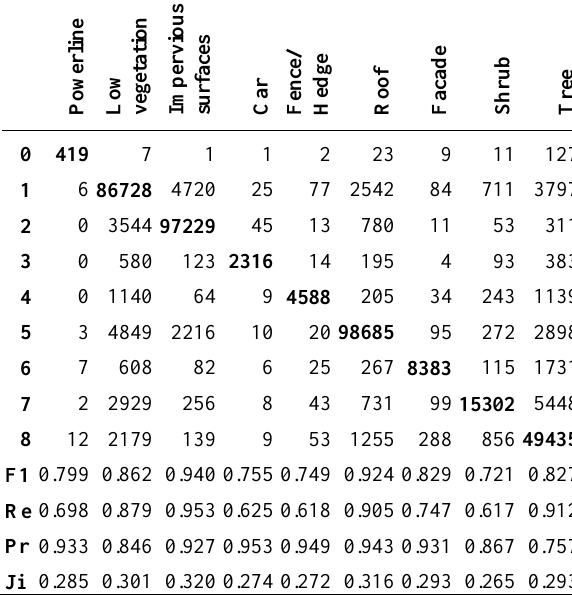
Table 3. Error matrix for best RF and accuracy indices (eq. 6). column headers are class labels, row names